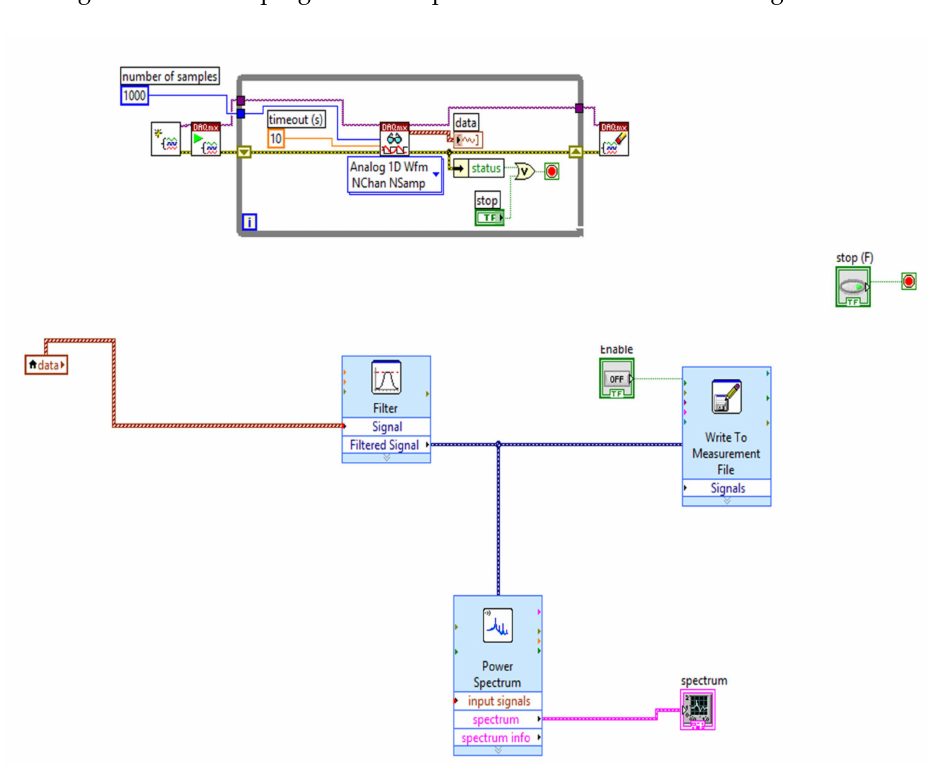
Figure 6. The program developed in LabVIEW for determining the vibration